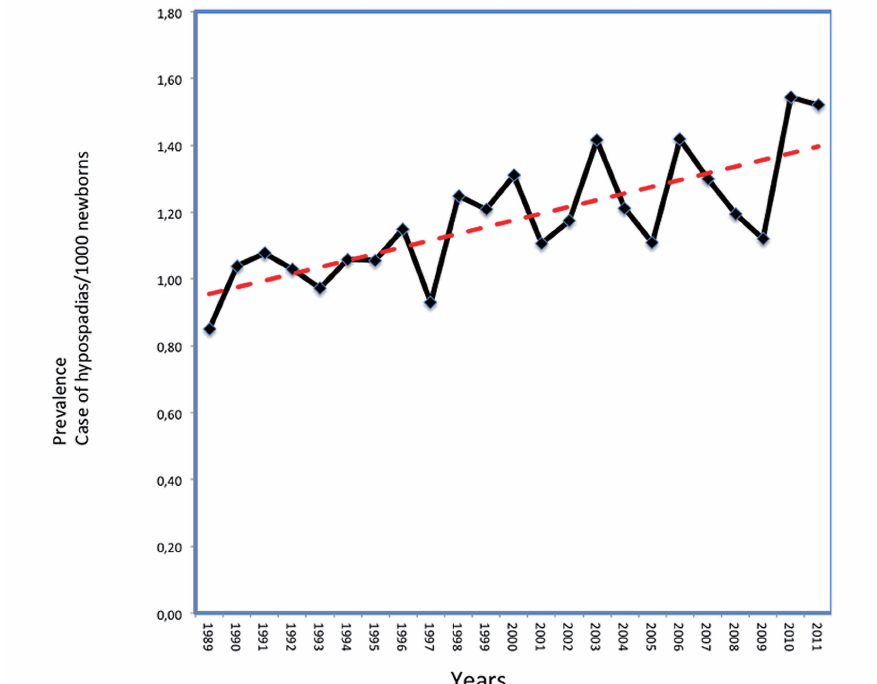
Figure 1 - Global prevalence trend of patients diagnosed with hypospadias at birth in 6 different countries in South America. The increasing trend is statistically significant.